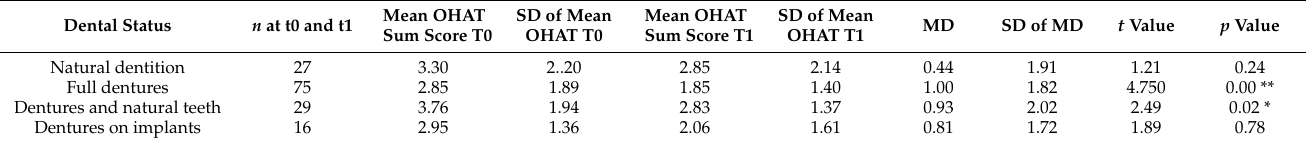
Table 5. Results of the paired t -tests of the mean OHAT sum scores at baseline (T0) and after 3 months (T1) within oral